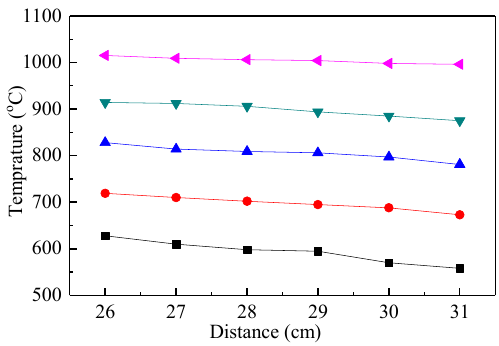
Figure 3. Observation port temperature field diagram.